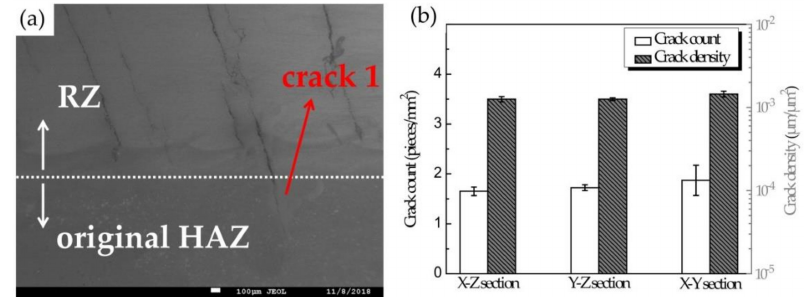
Figure 5. ( a ) The cracks on the X–Z section and ( b ) the crack count and density on three sections of as-deposited K417G. RZ—repair zone; HAZ—heat affected zone.